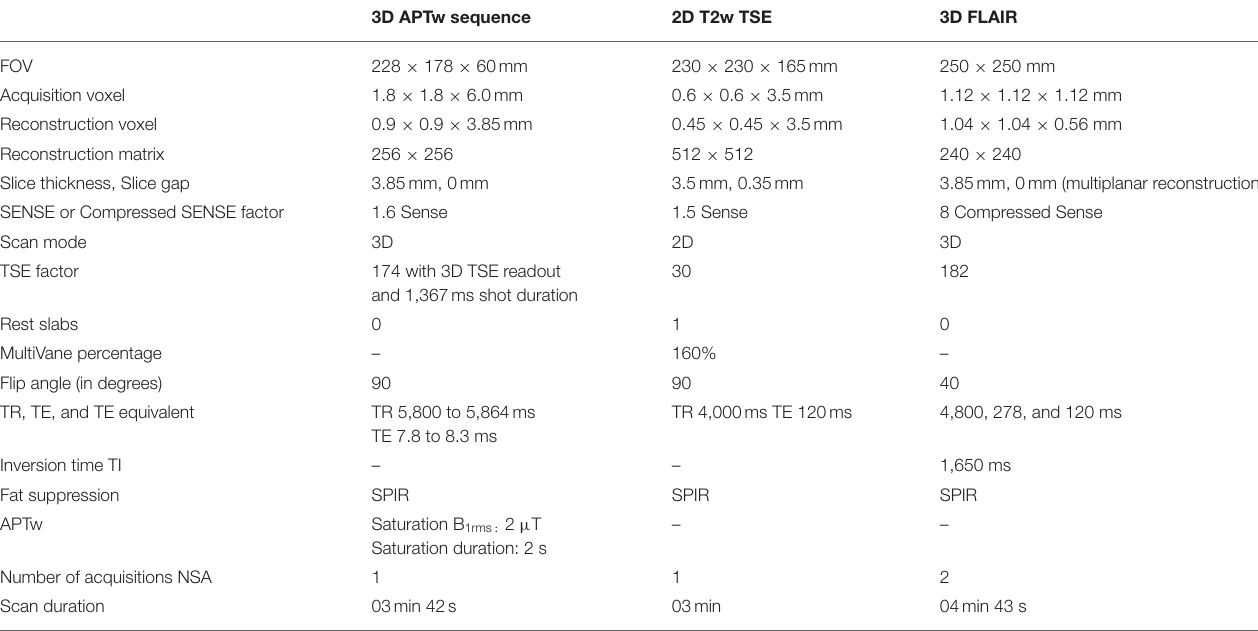
TABLE 1 | Scan parameters of the APTw, 2D T2w TSE, and 3D FLAIR